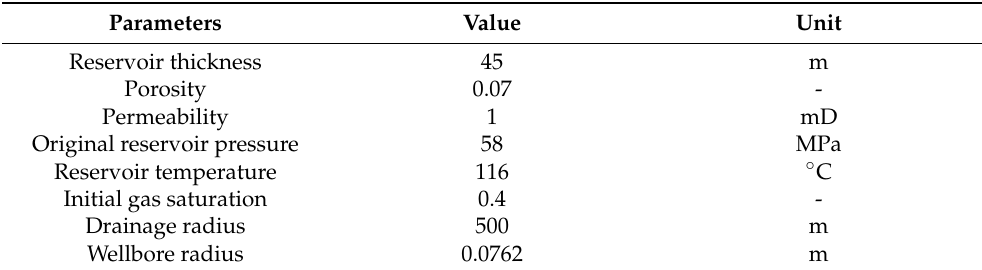
Figure 5. Comparison of the calculation results and simulated results. Table 1. The key parameters obtained from the geological model for model validation.